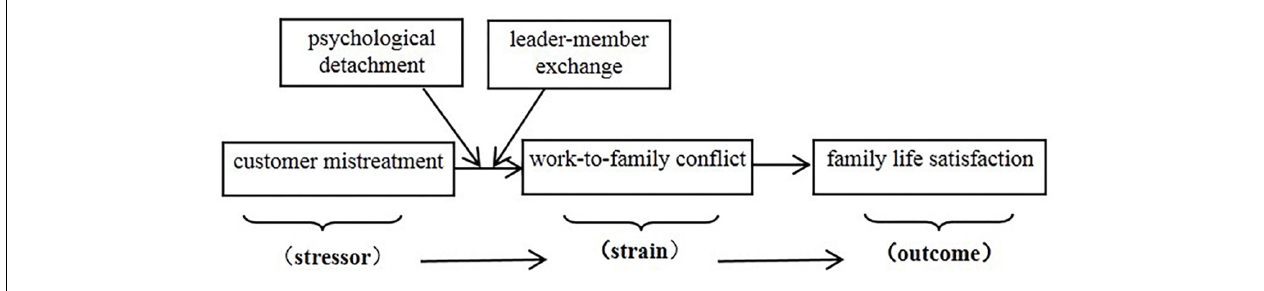
FIGURE 1 | The conceptual model of the